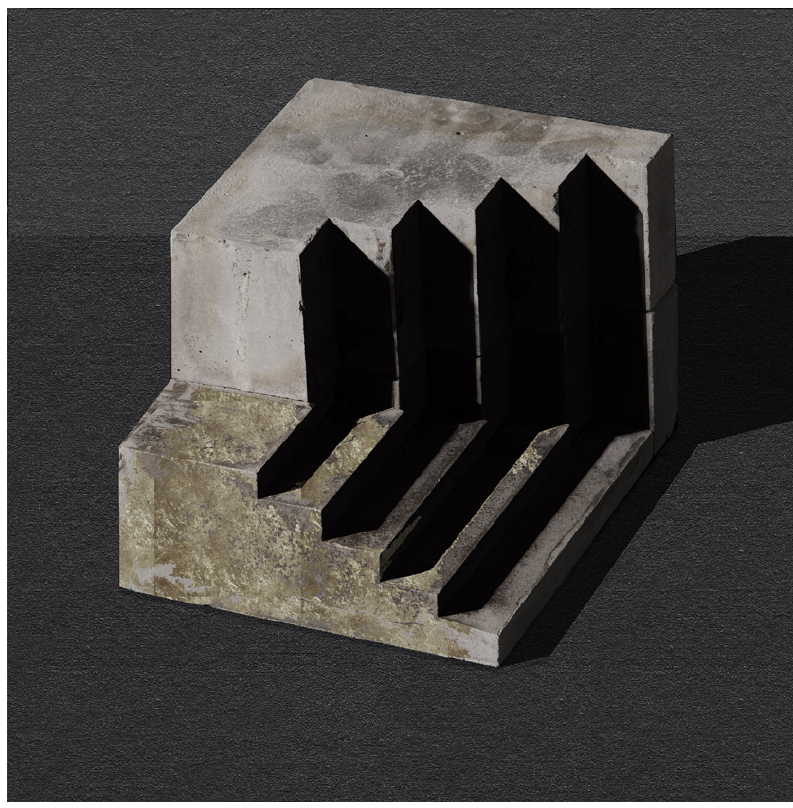
FIG. 5 Volumetric abstraction of a single module of a periacto as it is taken from the drawings by Leoncilli related to the exhibition of “Venezia e lo spazio scenico” (1979). Concrete maquette made by the author, scale 1:50. Photographer: Umberto Ferro, Laboratorio fotografico (Labfot)